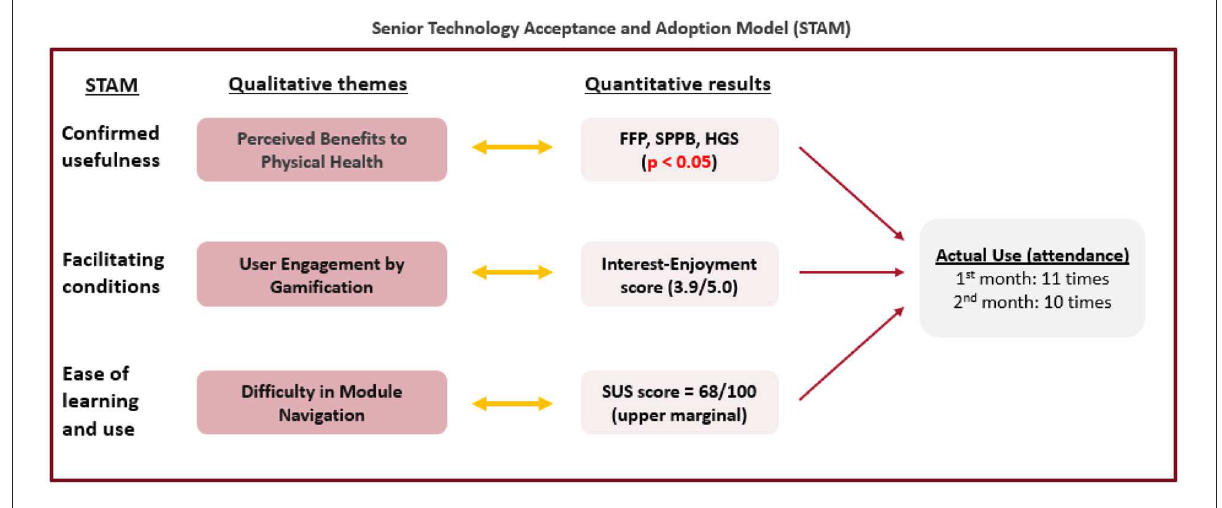
FIGURE5 Joint-display of qualitative themes and quantitative results using the senior technology acceptance and adoption model